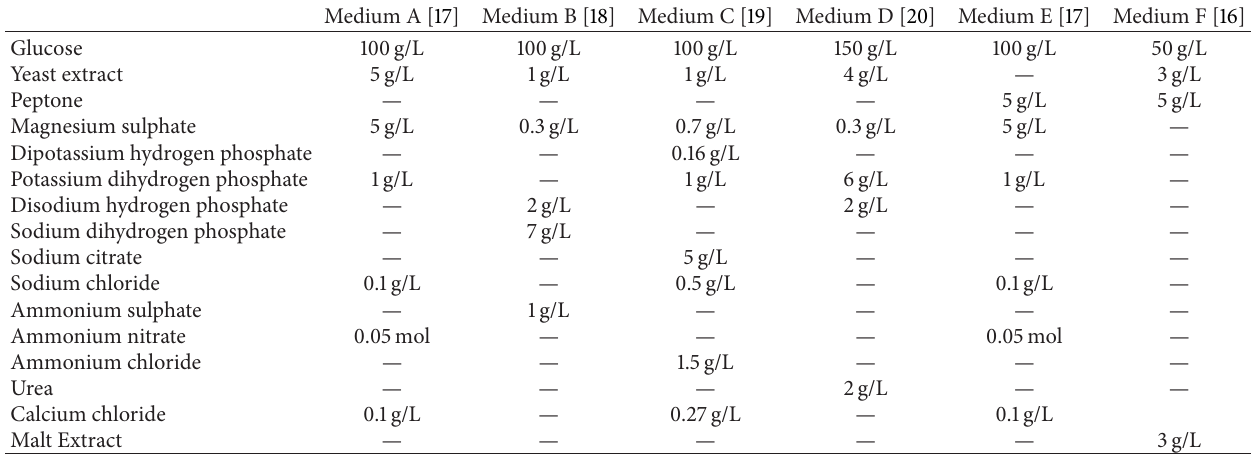
Table 2: Compositions of different media used during SL yield maximization